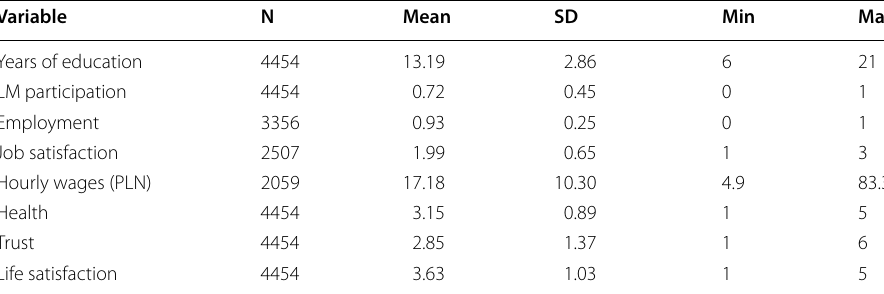
Table 9 Summary statistics of life outcomes